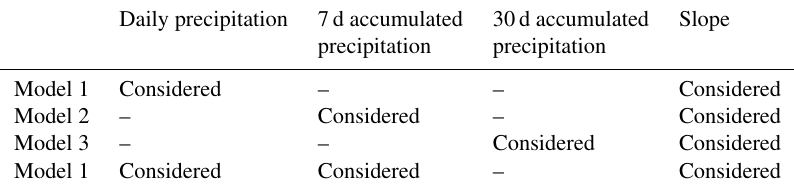
Table 1. Models and predictors incorporated. Daily precipitation 7d accumulated 30d accumulated Slope precipitation precipitation Model 1 Considered – – Considered Model 2 – Considered – Considered Model 3 – – Considered Considered Model 1 Considered Considered –